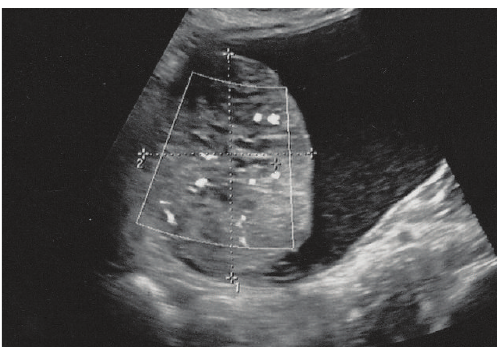
Figure 1: Ultrasound showing a complex mass, with a solid compo- nent.